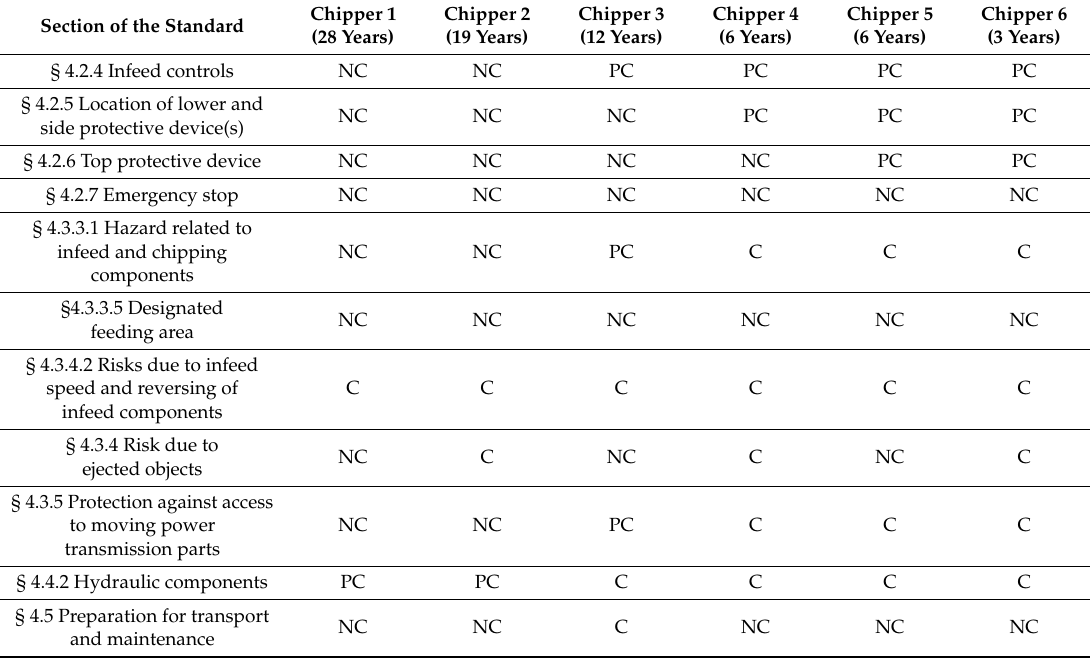
Table 1. Summary of results of the inspections on in-use wood chippers with regard to how they conform to the revised version (6th revision draft) of EN 13525